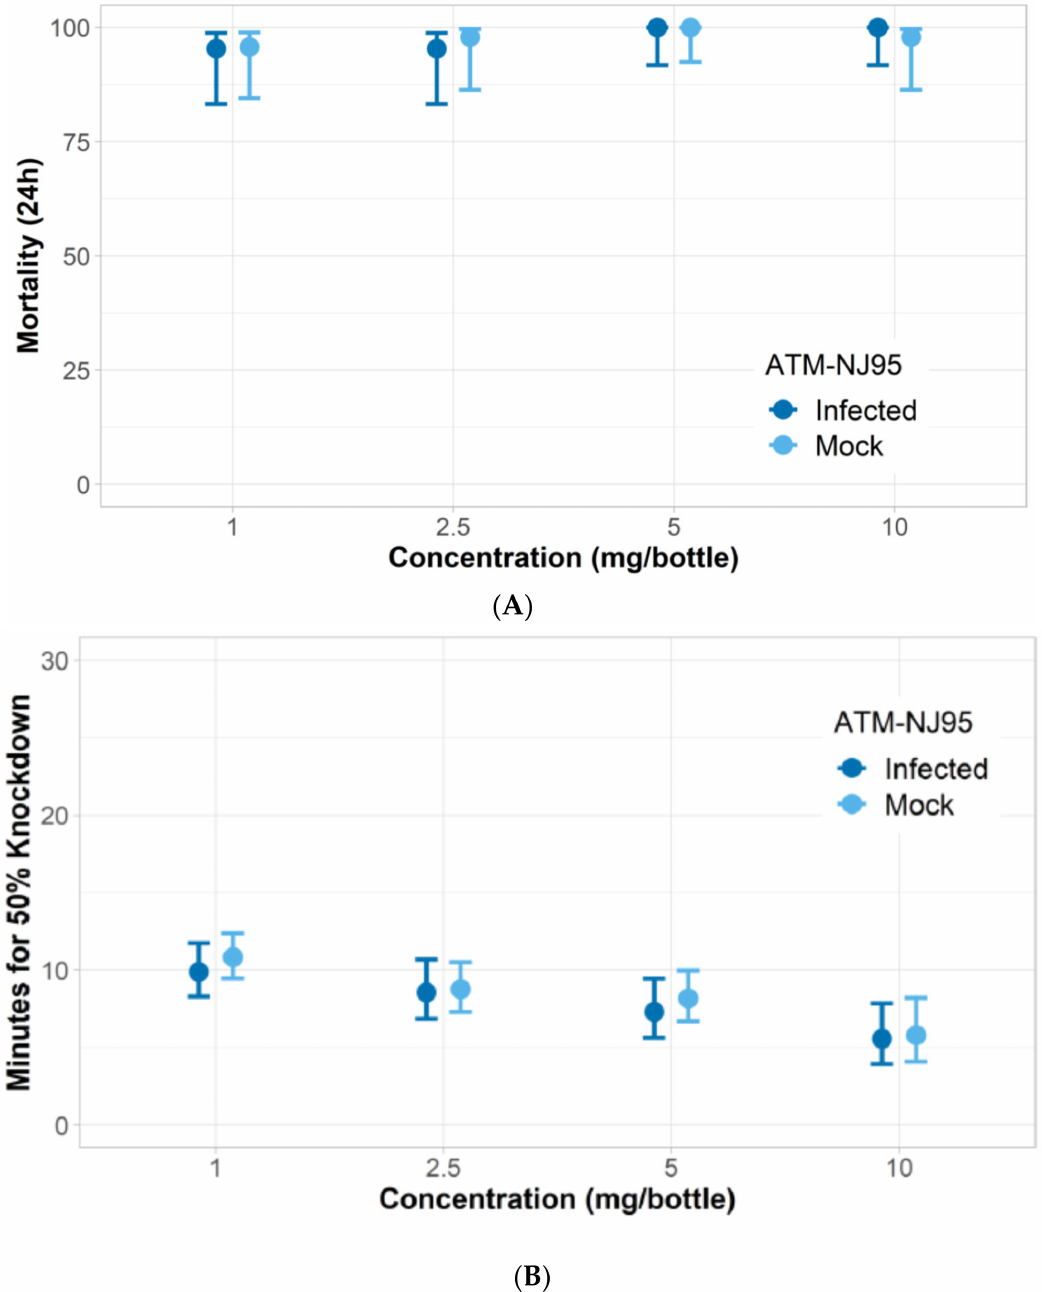
Figure 6. Response of A. albopictus ATM-NJ95 Zika-infected (infected) and uninfected (mock) mosquitoes when exposed to four concentrations of nootkatone (mg/bottle). ( A ) Mortality at 24 h and, ( B ) 50% of knockdown time in